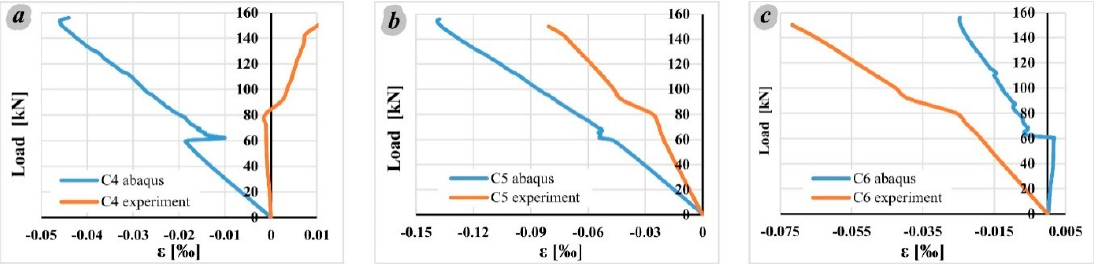
Figure 25. Experimental and numerical (model FEM B) strains of member W1 in gauges: ( a ) C4, ( b ) C5, and ( c ) C6. Appl. Sci. 2020 , 10 , x FOR PEER REVIEW